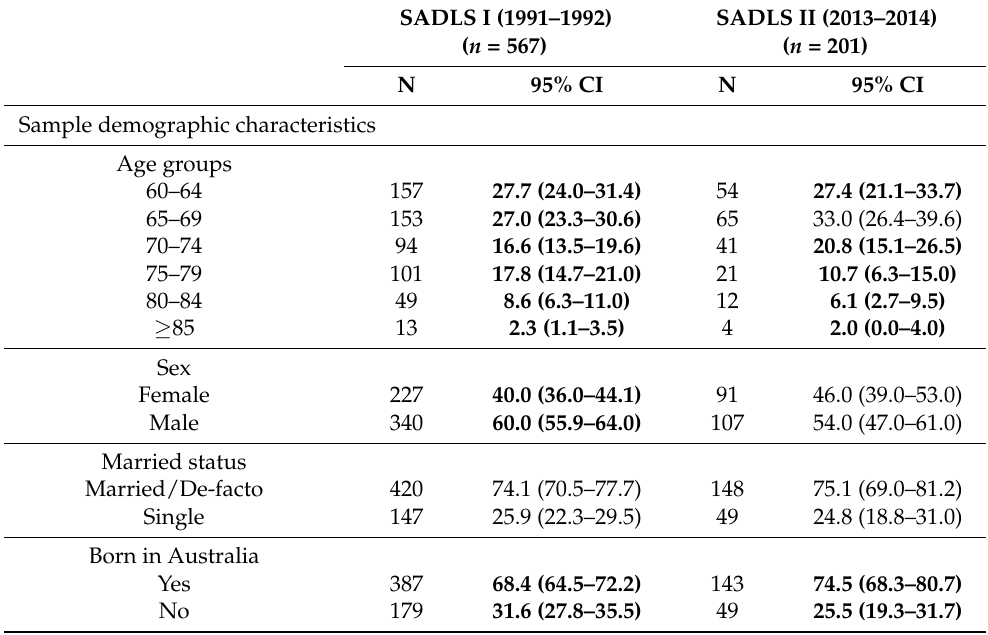
Table 2. Sample characterisers of two cohort of older Australian adults at baseline. SADLS I